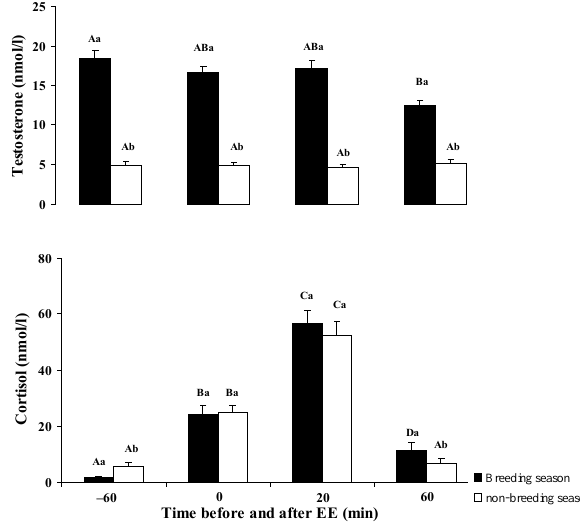
Figure 2. Mean ( ± SEM) plasma testosterone and cortisol level prior to and following electro-ejaculation (EE) stimulation during breeding and non-breeding season. Values for each hormone with different letters within breeding and within non-breeding season (ABC) significantly differ ( P< 0 . 05). Values for each hormone with different letters between breeding and non-breeding season (ab) sig- nificantly differ ( P< 0 .